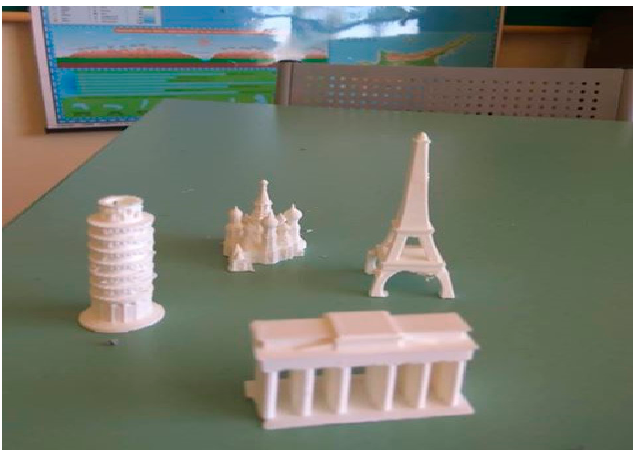
Figure 2. The 3D printed player tokens.